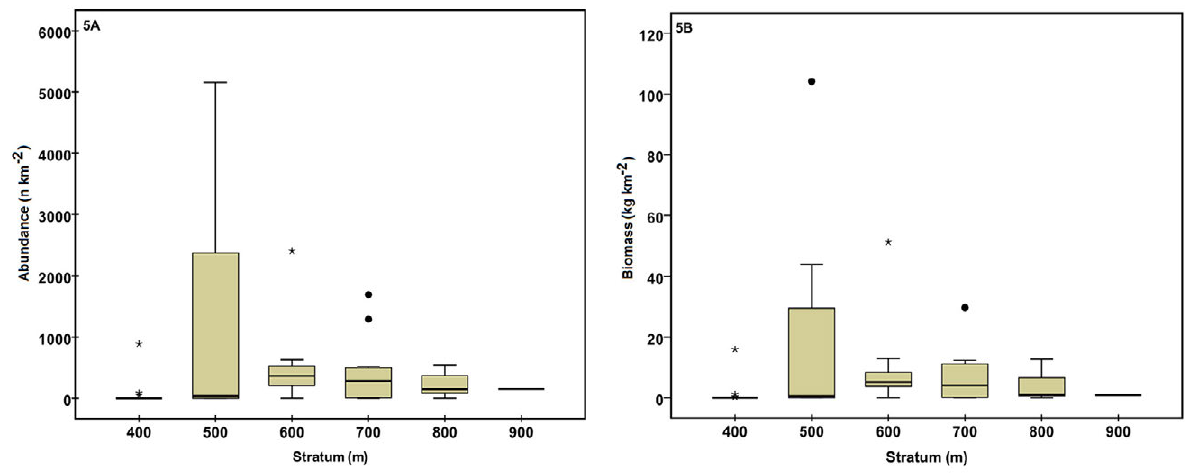
Fig. 5. – Box and whisker plot representations of the spatial variation of the abundance and biomass indices of A. antennatus from STRATUM